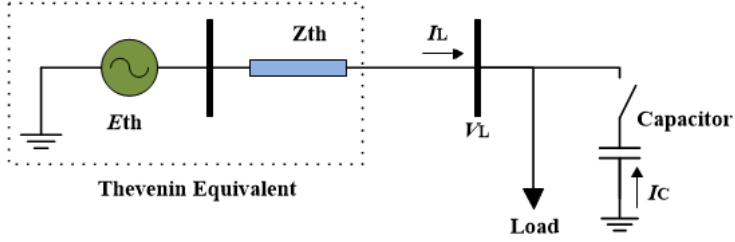
Figure 3. Thevenin equivalent of the system seen at the capacitor